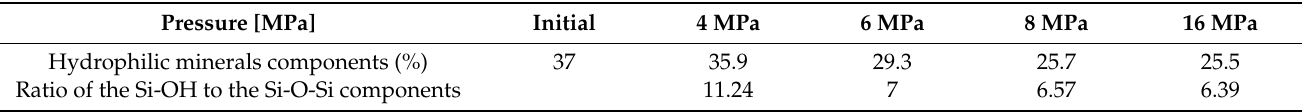
Table 4. Changes of shale (LM 3) under different pressures after shale reacted with CO 2 for 4 d at 40 °C [56].